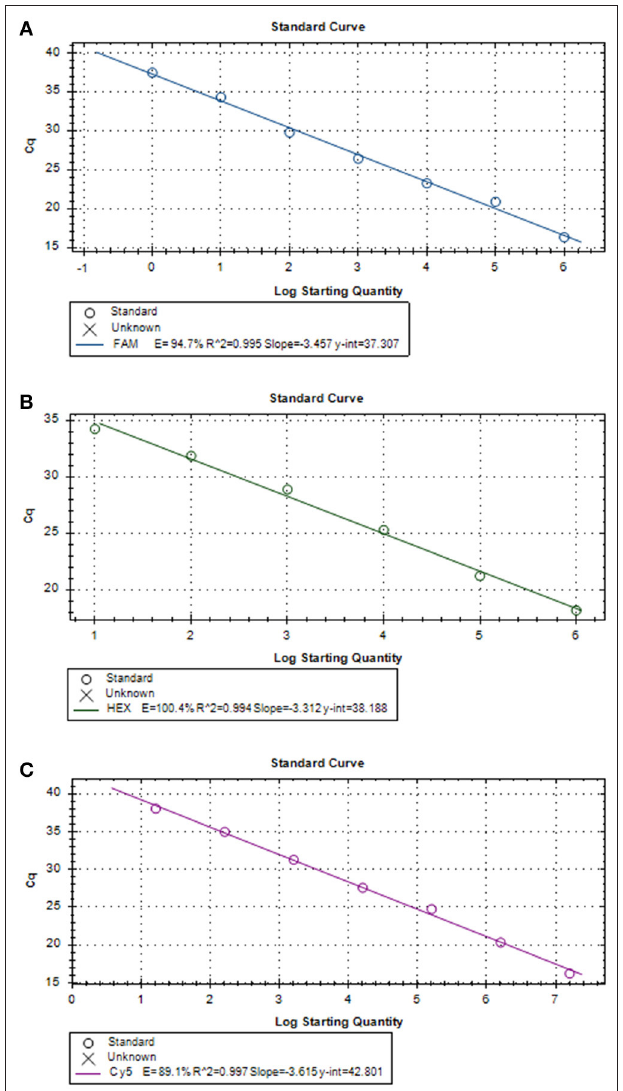
FIGURE 2 | Amplification curves in the sensitivity tests of triplex RT-PCR. (A) Sensitivity test for B646L gene. (B) Sensitivity test for EGFP gene. (C) Sensitivity test for mCherry gene.